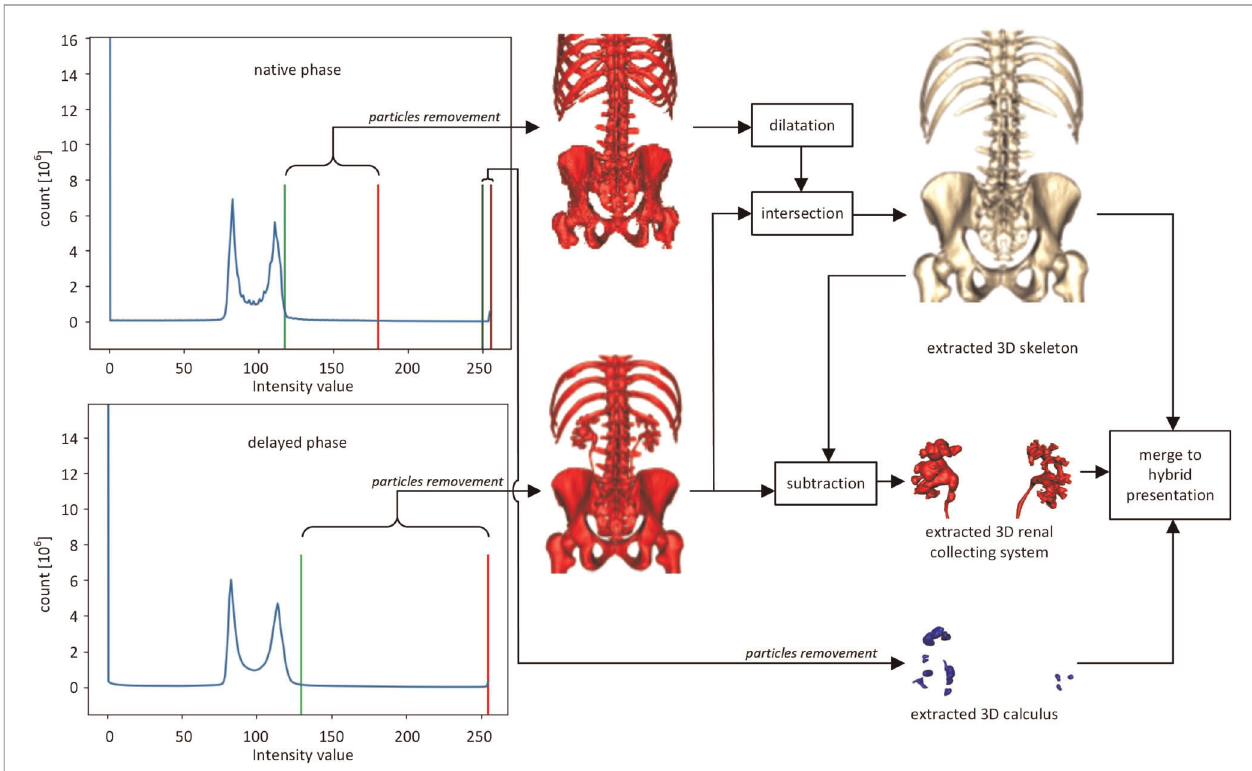
FIGURE 1 | The fl ow chart of the segmentation and 3D rendering